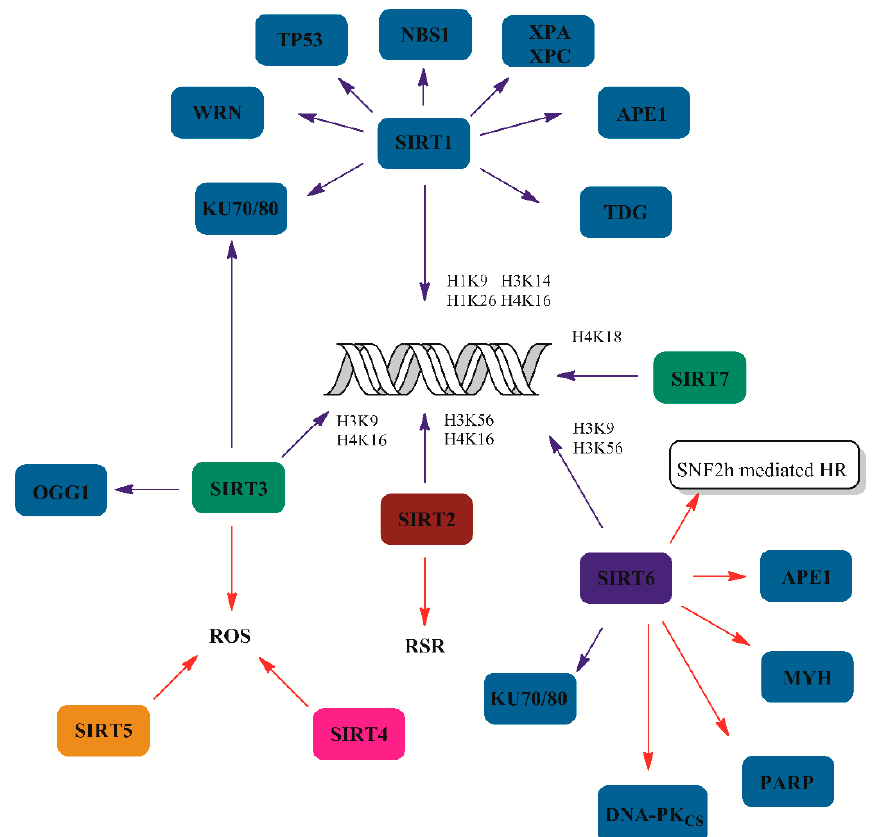
Figure 2. Role of sirtuins (SIRTS) in DNA repair. Blue lines indicate deacetylation reactions. Red lines represent other interactions between sirtuins and DNA damage response components. Most sirtuins, excluding SIRT4 and SIRT5, possess deacetylase activity toward multiple acetylated lysine residues of histone proteins. SIRT1 and SIRT6 have a wide range of substrates including BER (DNA glycosylases MYH and TDG; AP endonuclease APE1) and NER components (xeroderma pigmentosum proteins XPA and XPC), DSB proteins including KU protein, nibrin (NBS1), DNA-dependent protein kinase, catalytic subunits (DNA-PKcs), PARP1, and other DDR-related factors such as WRN and TP53 protein. Mitochondrial sirtuins (SIRT3, SIRT4 and SIRT5) prevent ROS-induced DNA damage in mitochondria. SIRT3 deacetylates and stimulates the activity of OGG1 glycosylase.